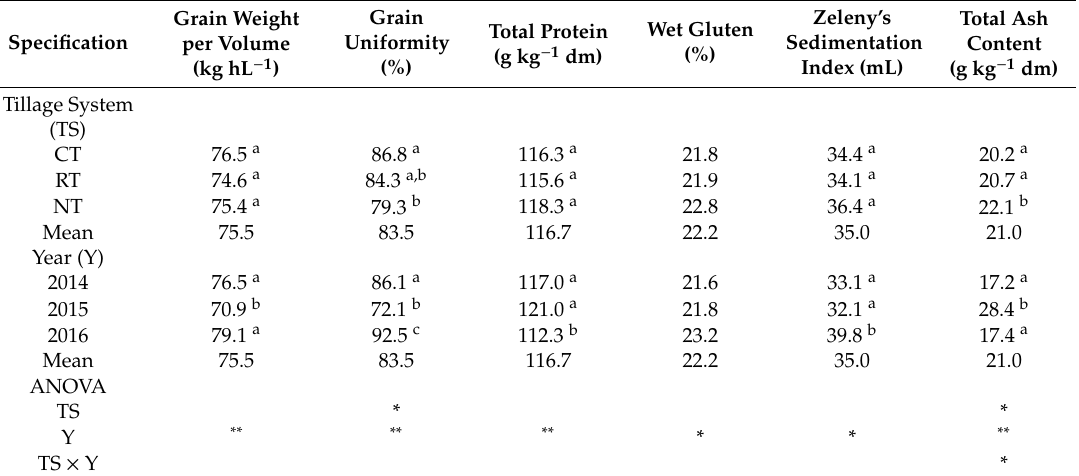
Table 2. Quality parameters of winter wheat